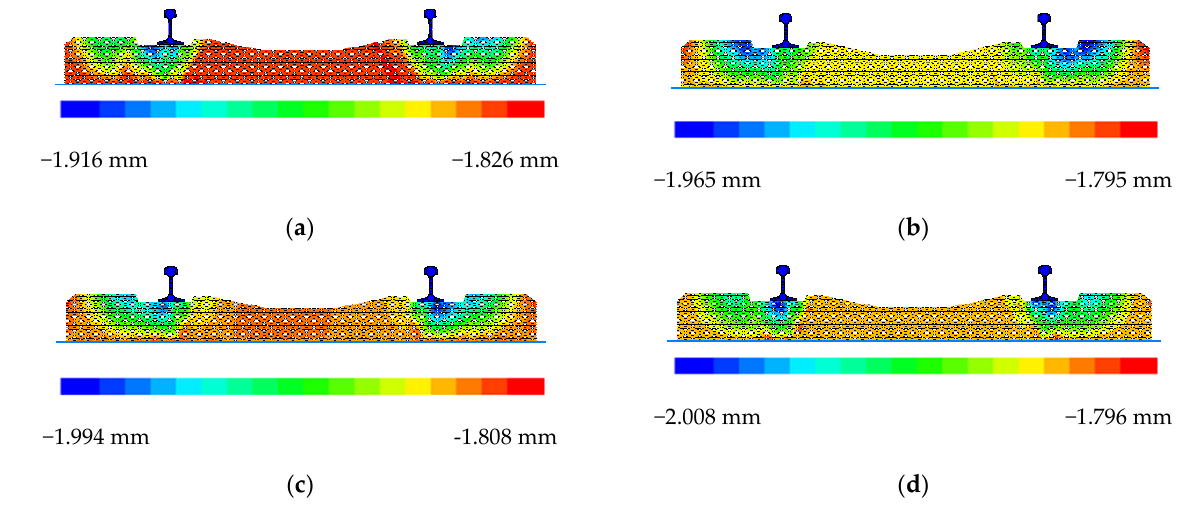
Figure 9. Vertical displacement cloud diagram of sleepers corresponding to different loading fre- quencies. ( a ) 5 Hz. ( b ) 10 Hz. ( c ) 20 Hz. ( d ) 50 Hz.